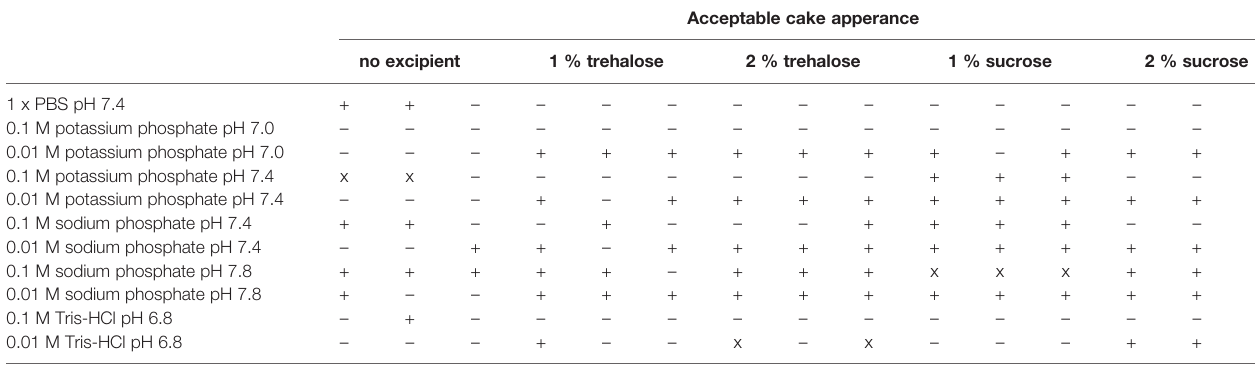
TABLE 1 | Buffer formulation screening based on lyophilized cake optical appearance immediately after freeze-drying in microtiter